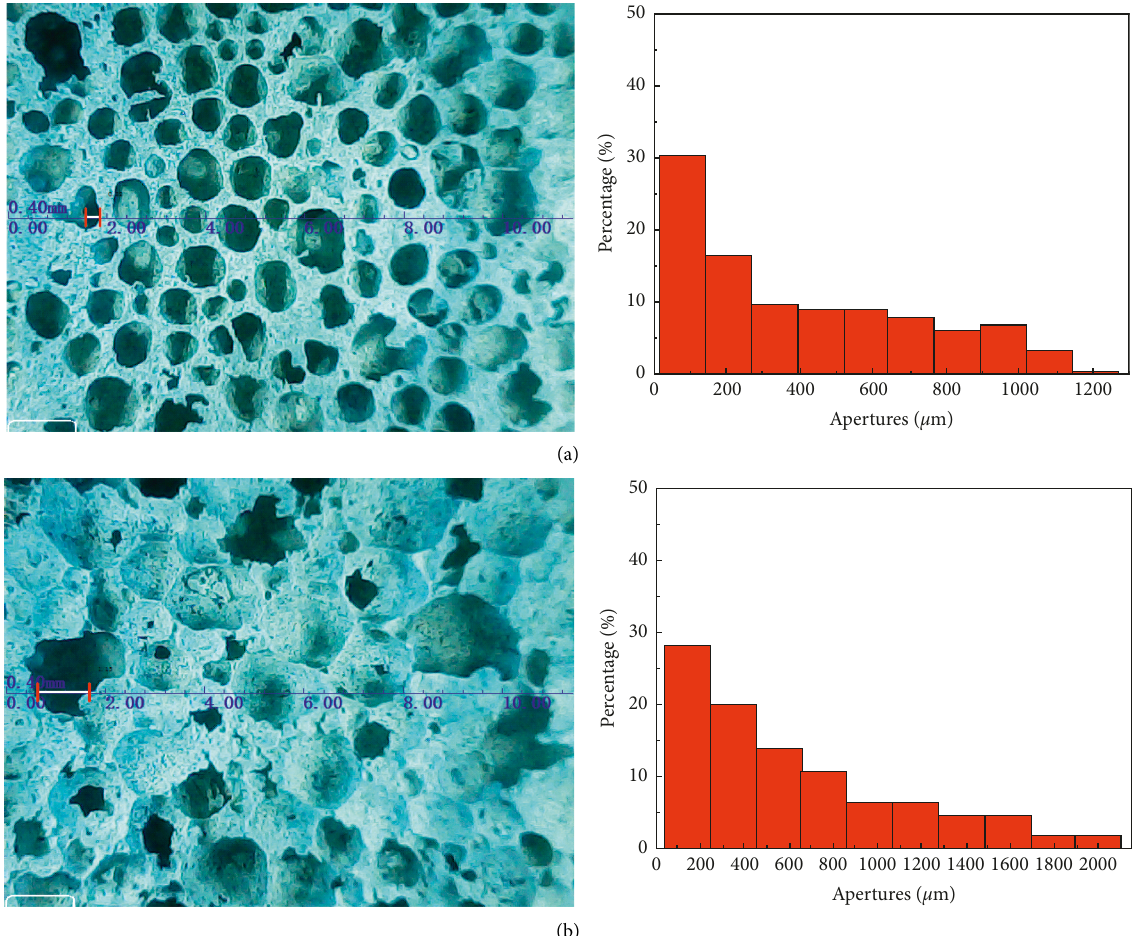
Figure 4: Microstructure photographs and pore size distribution of AFC sample cross section: (a) AFC-2 (without NSAP) and (b) AFC-7 (with NSAP).